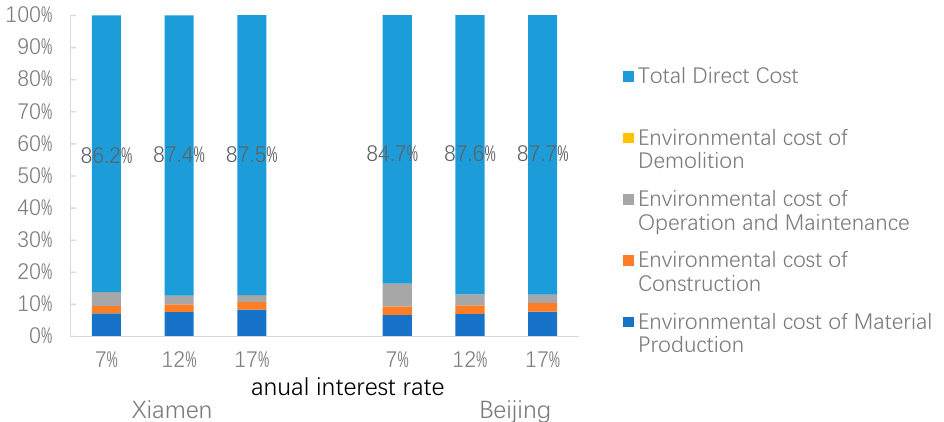
According to the results of both case studies (see Figure 5), a default discount rate was selected